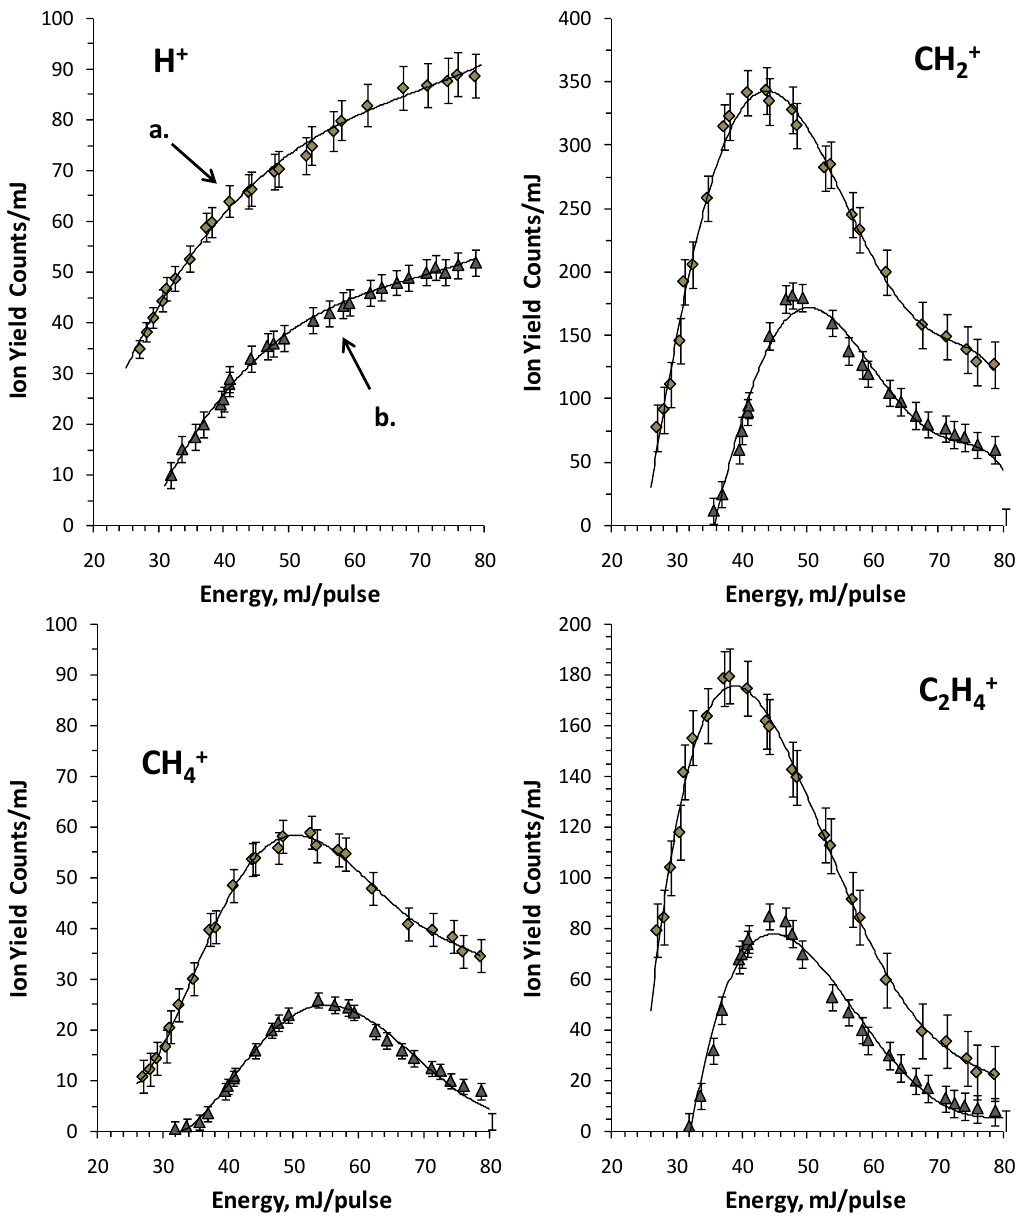
Figure 3. Comparative carrier gas effect in PD of tetracene at 355 nm: a) without carrier gas; b) with argon as carrier